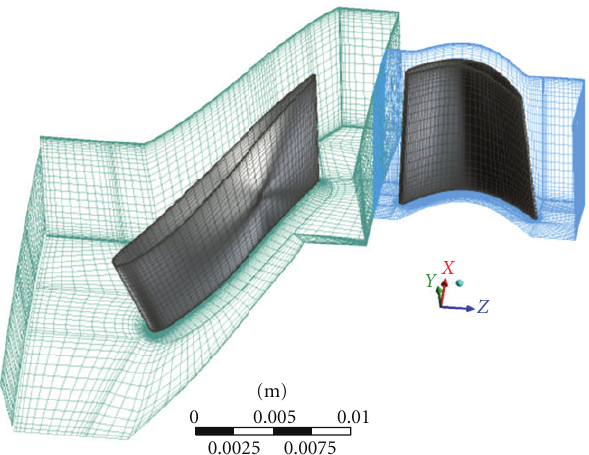
Figure 4: Computational grids of the NASA-designed